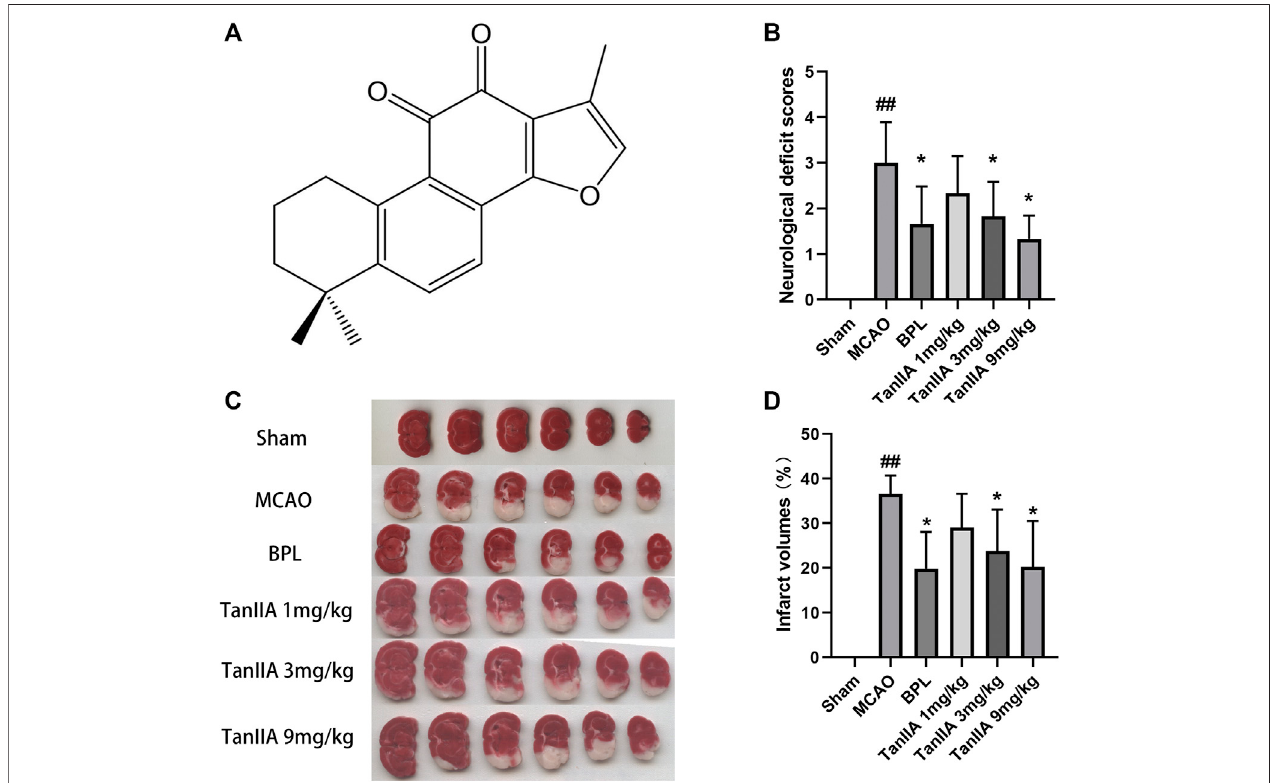
FIGURE 1 | Tanshinone IIA treatment ameliorated neurological de fi cits and reduced infarct volumes in rats. Tanshinone IIA, BPL or control saline was injected into the tail vein at the indicated time after occlusion. After 24 h, the neurological de fi cit scores were measured, and the rats were euthanatized and the brain sections were stainedwithTTCforinfarctvolumemeasurement. (A) ThemolecularstructureofTanshinoneIIA. (B) Theneurologicalde fi citscoresofratsineachgroup. (C) TTCstaining in each group. (D) Statistical results of cerebral infarct volumes in each group. ## p < 0.01, compared with the Sham group. * p < 0.05, compared with the MCAO group. Sham, sham operation group; MCAO, middle cerebral artery occlusion; BPL, butyphthalide (positive control); TanIIA, Tanshinone IIA, n (cid:1)